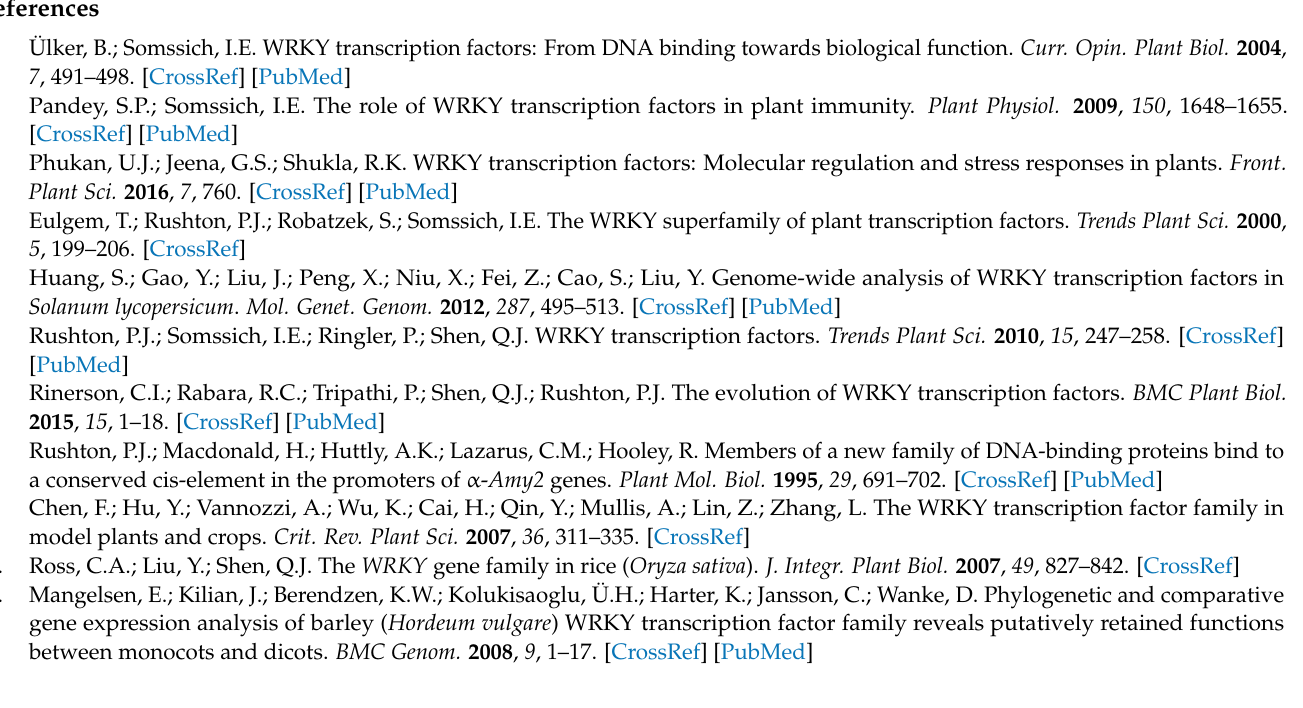
Table S3: Primer sequences for vector